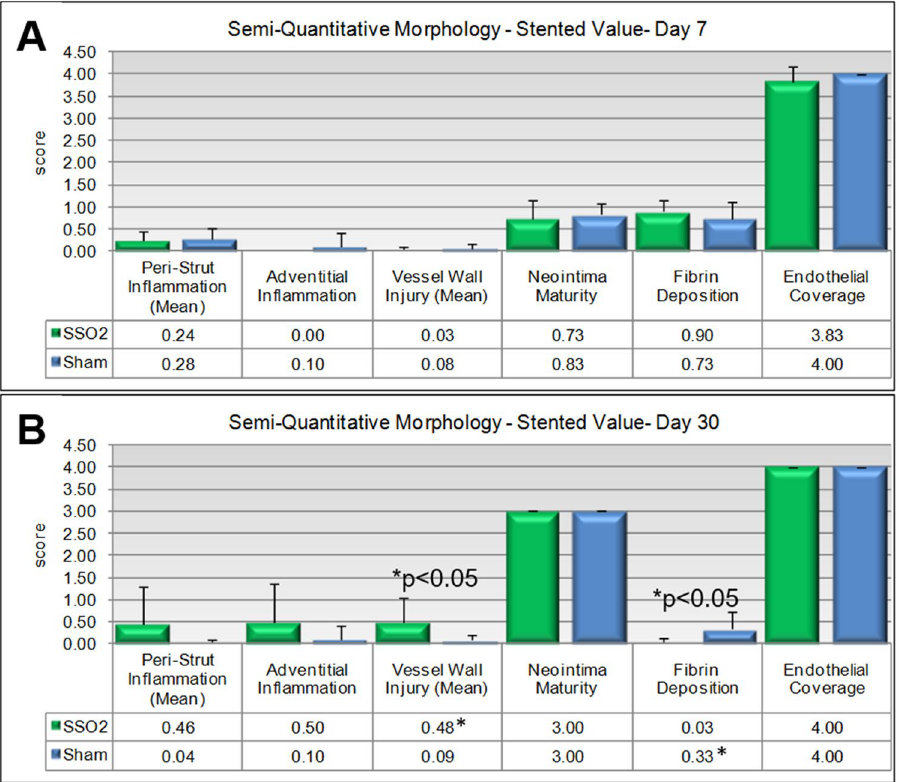
Figure 5. Key semiquantitative metrics of arterial healing at 7 days ( A ) and at 30 days ( B ). Overall, there is no negative impact of SSO 2 therapy on the arterial healing parameters in comparison to sham. The incidental statistically significant differences in injury and fibrin deposition are discussed in the